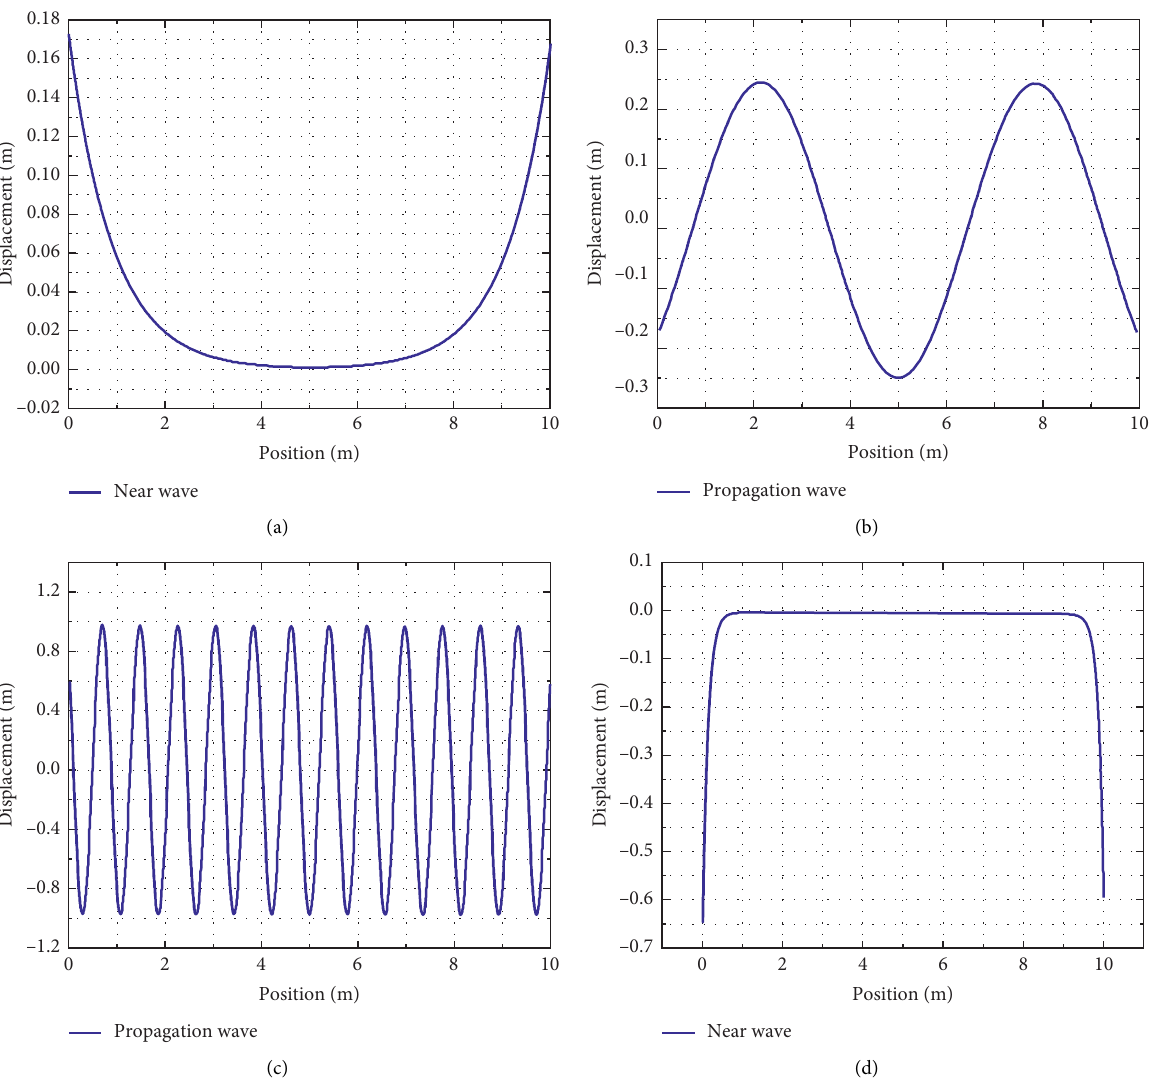
Figure 9: Wave component diagram, (a) near wave component (exp ( k component (exp ( k 2 x )), and (d) traveling wave component (exp ( k 4 x )).